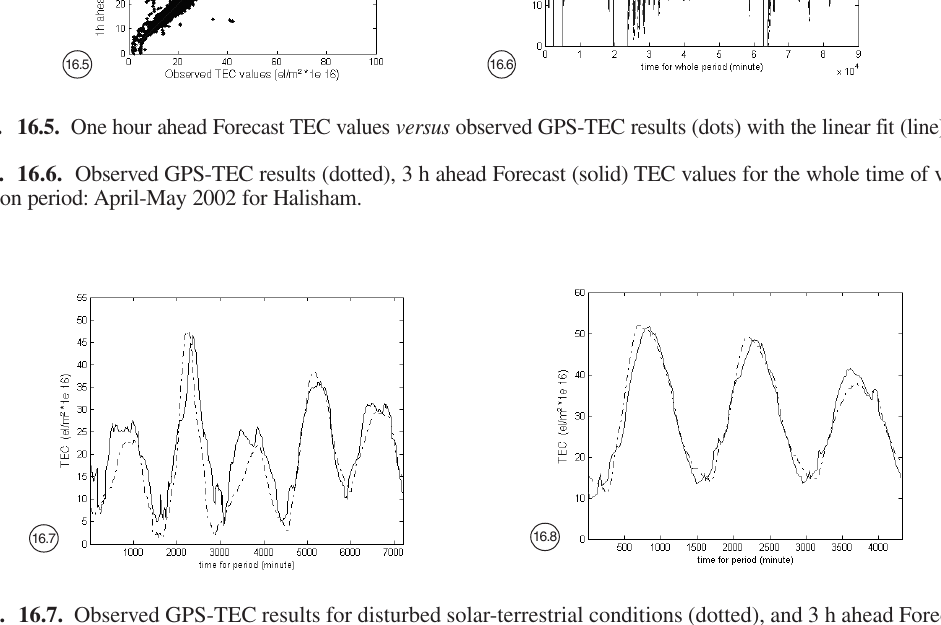
Fig. 16.7. Observed GPS-TEC results for disturbed solar-terrestrial conditions (dotted), and 3 h ahead Forecast (solid) TEC values for the enlarged portion of the time of validation period: 18-22 April 2002. Fig. 16.8. Observed GPS-TEC results for quiet solar-terrestrial conditions (dotted), and 3 h ahead Forecast (sol- id) TEC values for the enlarged portion of the time of validation period: 5-7 April 2002.